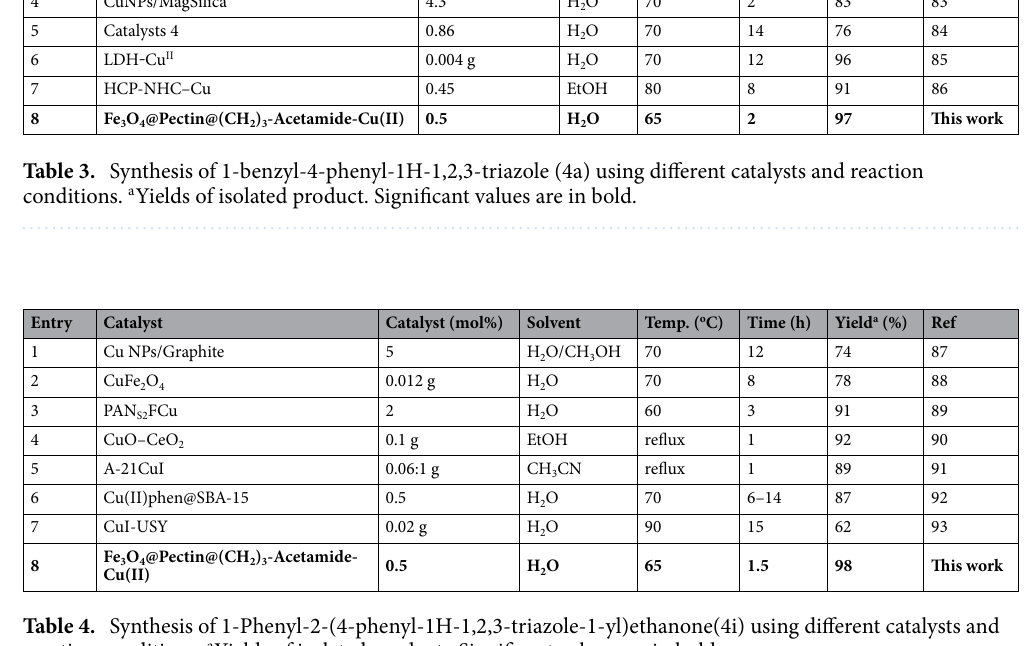
Table 4. Synthesis of 1-Phenyl-2-(4-phenyl-1H-1,2,3-triazole-1-yl)ethanone(4i) using different catalysts and reaction conditions. a Yields of isolated product. Significant values are in